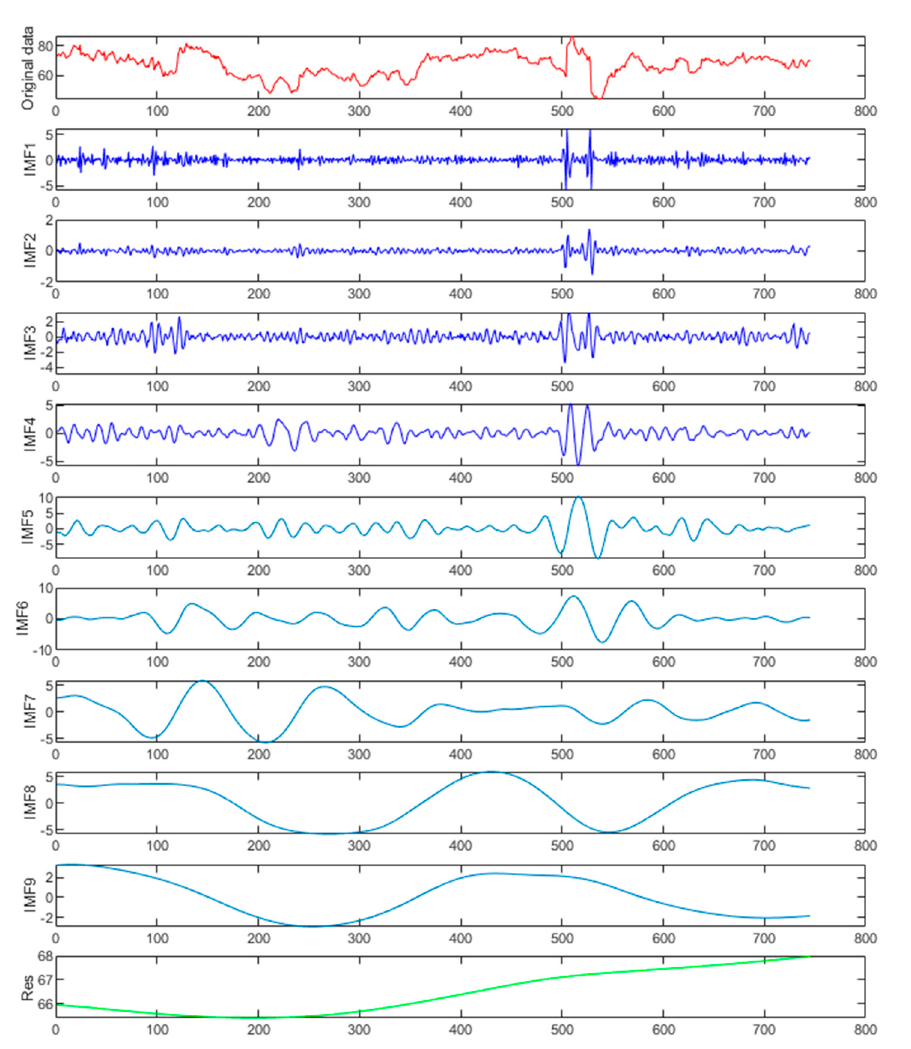
Figure 7. The PWV decomposition results for CEEMDAN. IMFn represents the nth subcomponent obtained from CEEMDAN. Res indicates the PWV trend after decomposition.